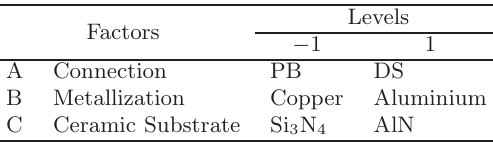
Fig. 12. Power cycling profile. Table 6. DoE factors and levels.